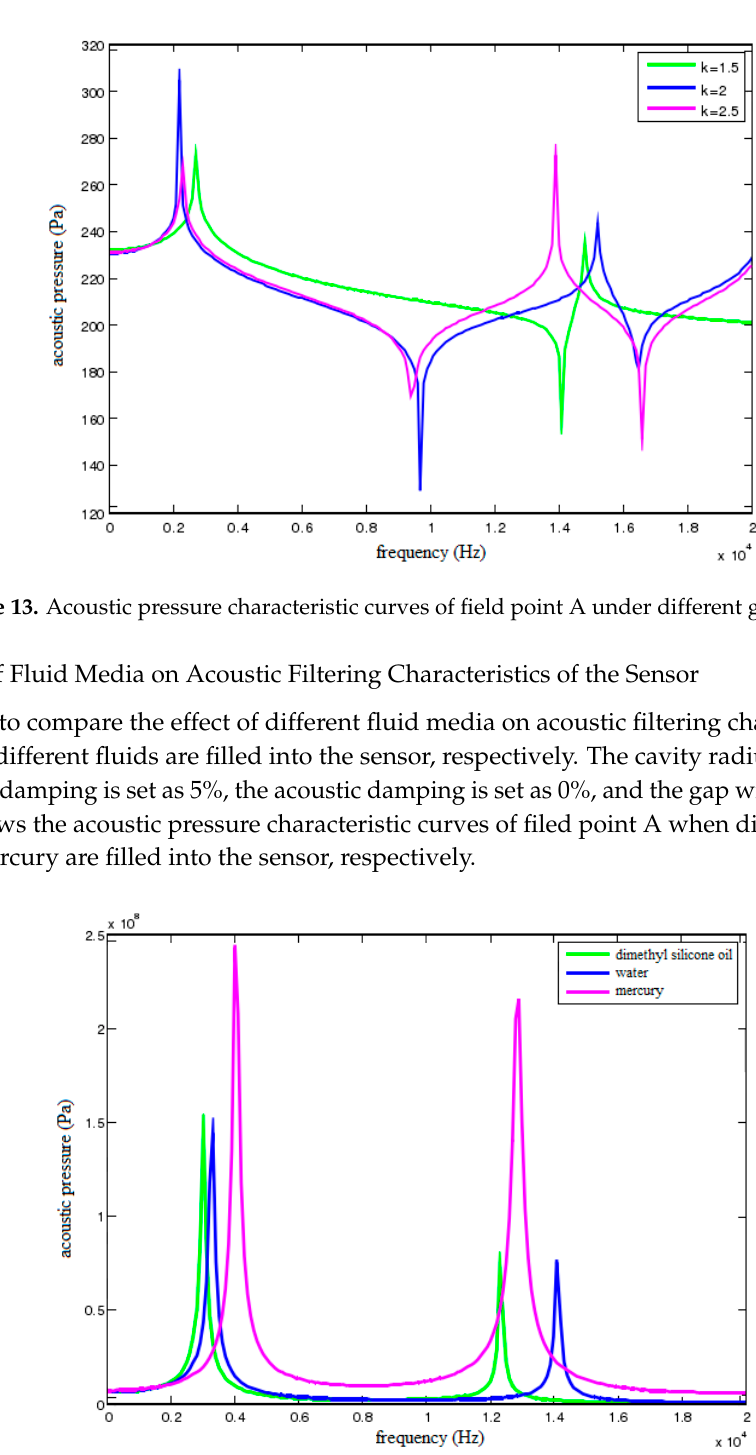
Figure 14. Acoustic pressure characteristic curves of field point A filling with different fluids.